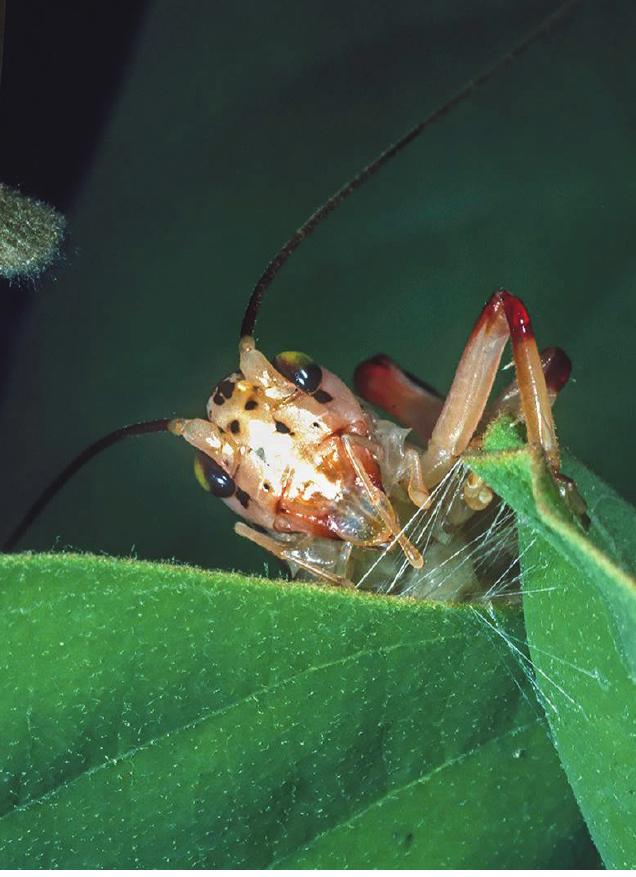
Fig. 7. The same individual as in Fig. 5; spinning silk strands to secure leaves for shelter construction.